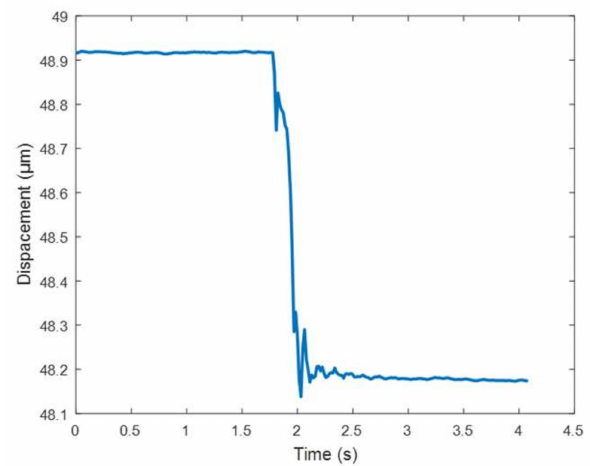
Figure 19. Displacement change at 5